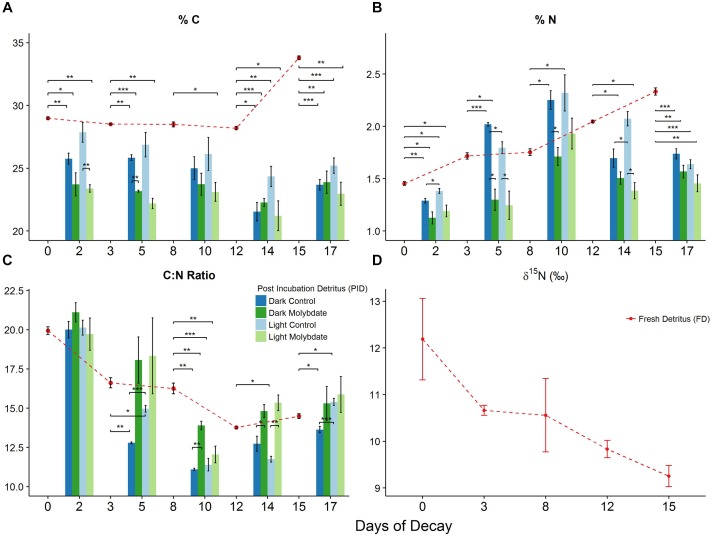
Changes in %C (A), %N (B) and C:N ratio (C) associated with decomposing S. horneri in control (blue) and molybdate amendments (green) in both dark and light incubations as well as pre-incubation samples (red dashed line) (2017). Additional changes in δ15N (D) with fresh detritus throughout decomposition (error bars represent SE). ∗p < 0.05, ∗∗p < 0.01, ∗∗∗p < 0.001.